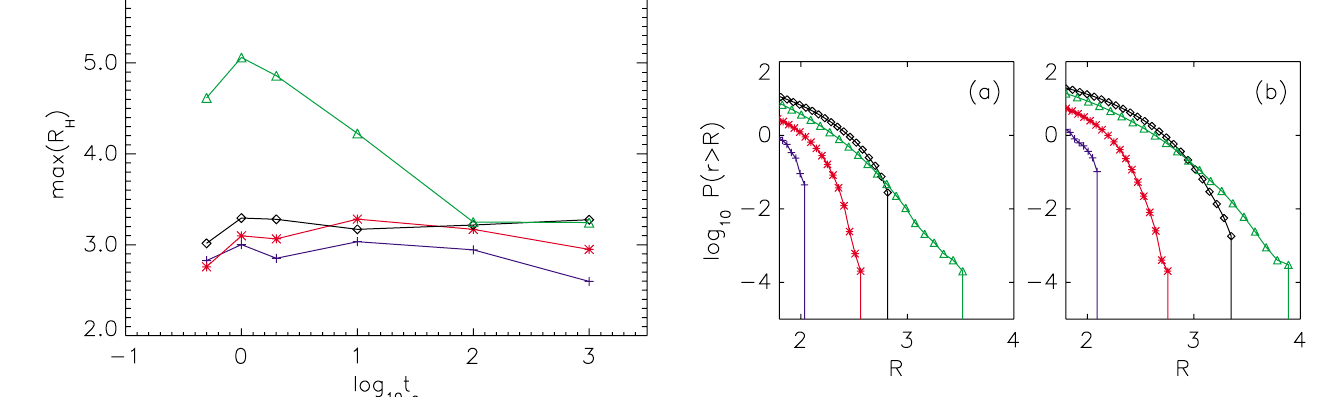
(cid:2) 0 : 05 and 1 (cid:2) 80 and (cid:13) (cid:2) 0 . Blue c 2